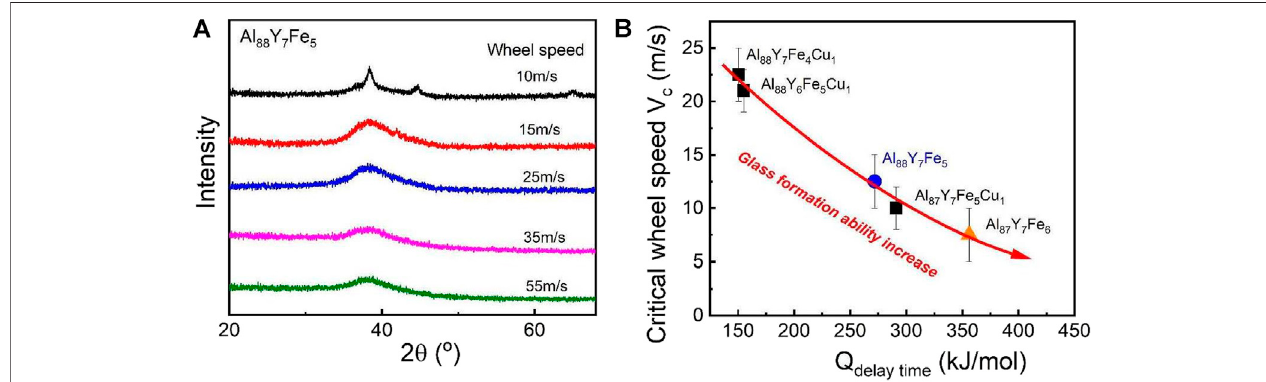
FIGURE 9 | (A) The determination method of the critical wheel speed range for glass formation of Al 88 Y 7 Fe 5 based on XRD. (B) Correation between the delay time activation energy and critical wheel speed for glass formation for Al-Y-Fe MG systems (from Gao et al.